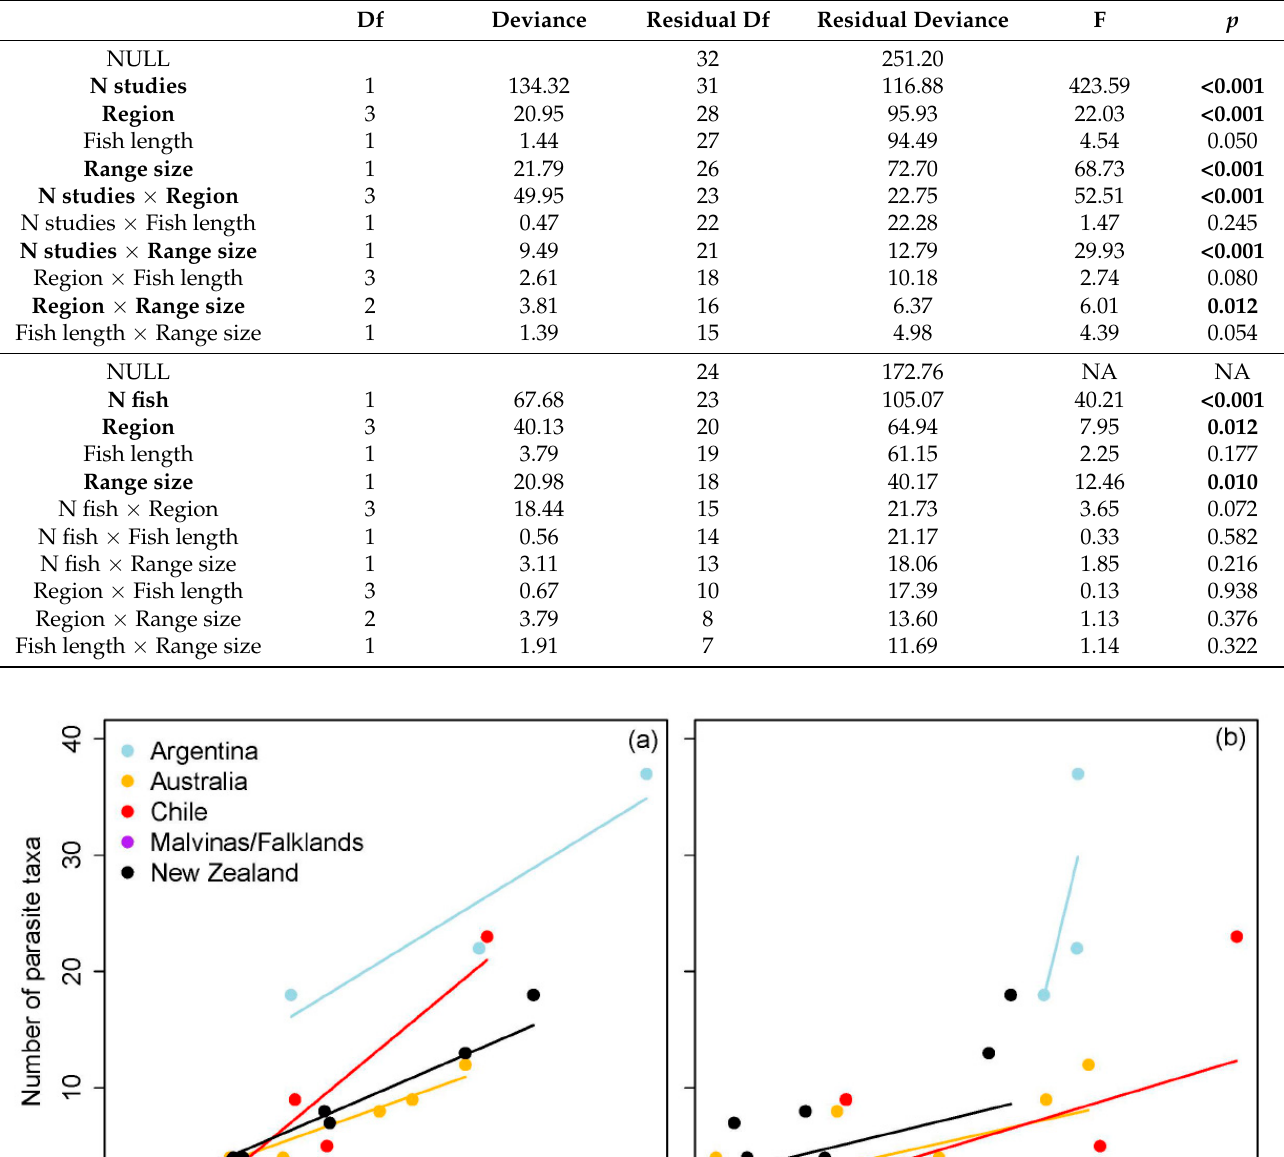
Table 2. Influence of study effort (number of studies or fish), geographical region, fish length (standard), and latitudinal range size (km) on the number of parasite taxa reported from galaxiid fish. Statistically significant differences in parameters ( α = 0.05) are in bold.